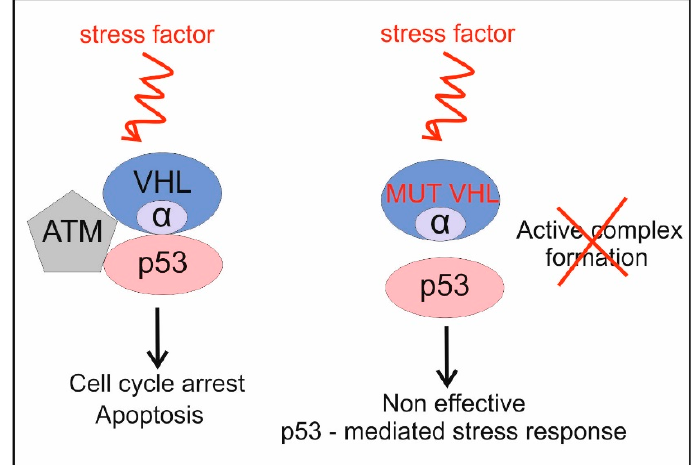
Figure 2. VHL interacts with p53, via its α domain, and also, with the ATM protein (Adapted from ref [21]). These interactions inhibit p53 degradation and eventually enhance the p53 response to stress. Mutations in the VHL gene probably result in the failure of the VHL–p53 interactions, and as a consequence, the p53-dependent stress response is inefficient.